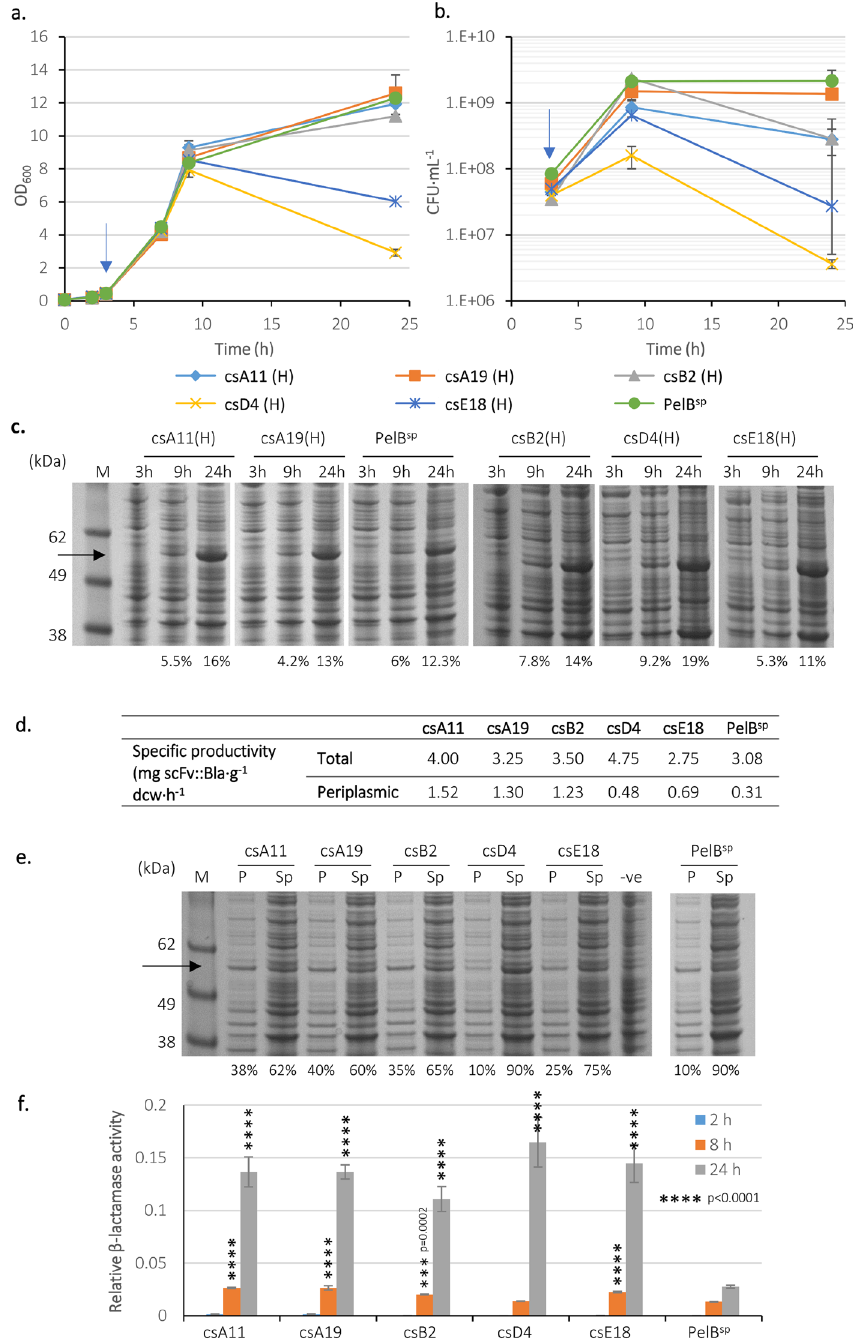
Figure 5. Analysis of selected clones from chemically synthesised (CS) signal peptide library. E . coli BL21-A carrying the vector encoding scFv::Bla with five high-activity signal peptides from the CS library were grown at 25 °C and indu ced with 0.02% arabinose at an OD 600 ≈ 0.5 (blue arrow). The OD 600 ( a ) and CFU ( b ) were measured. Data shown are mean values of two replica flasks and error bars are ± 1 standard deviation (n = 2). ( c ) SDS-PAGE analysis of whole cell lysates obtained before (3 h) and after induction (9 and 24 hours post-inoculation). M is the molecular size marker. ( d ) Specific productivity of total scFv and periplasmic scFv at 24 hours growth. Values calculated from densitometry data from panels ( c , e ) as described in supplemental materials and methods. ( e ) Periplasm (P) and spheroplast (Sp) fractions from cultures after 9 hours of growth. Negative control is the empty vector ( − ve) after 24 hours growth. The quantity of the scFv::Bla is expressed as percentage of whole cell protein ( c ) and the percentage of protein accumulated in each fraction ( e ). ( f ) The β -lactamase activity of each clone evaluated here. Error bars represent the 5% uncertainty in the calculation of the slopes corresponding to β -lactamase activity (n = 2), which is expressed in terms of change in OD 495 per minute per OD 600 . Asterices indicate values statistically significant ( **** p < 0.0001; *** 0.001 > p > 0.0001) compared to the control (PelB sp -scFv::Bla) after selecting adjusted p < 0.001 as the level of significance during statistical analysis of data. Uncropped gel images are available in Supplemental Fig.